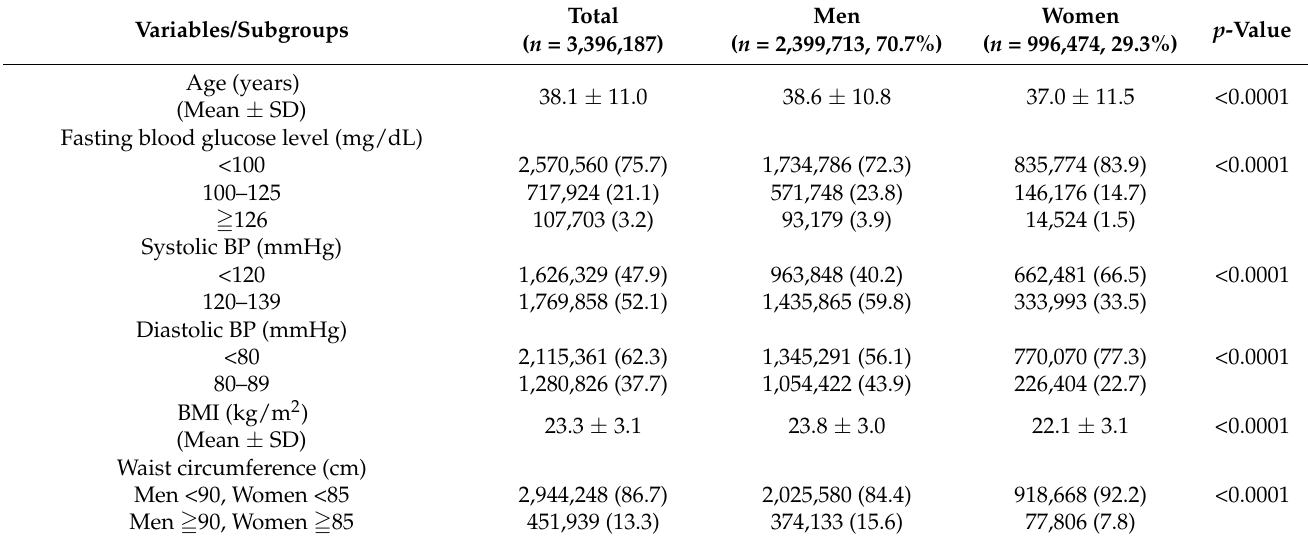
Table 1. Baseline characteristics of study